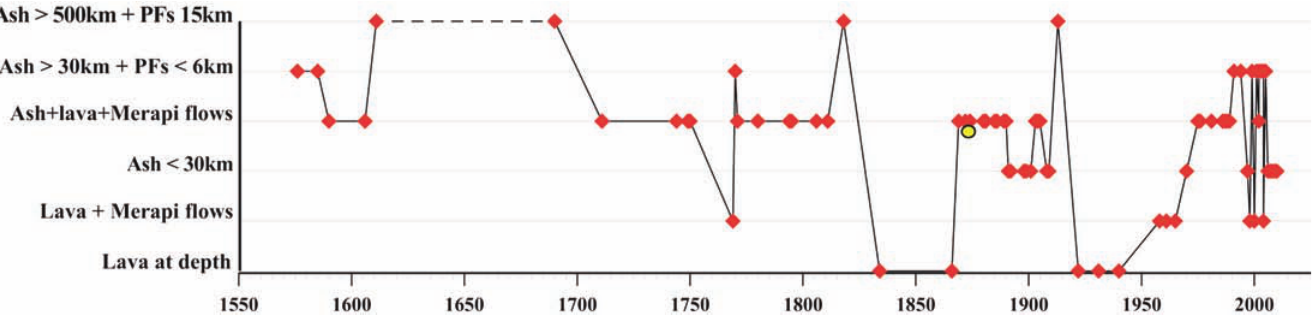
Figure 2. Colima Volcano historical activity. Based on: Tello 1651, Perez de Leon 1789, Mota Padilla 1742, Bárcena 1887, Puga 1889, Vizcarra 1891, Starr and Arreola 1903, Diaz 1906, Arreola 1915, Waitz 1932, Mooser 1961, Thorpe et al. 1977, Luhr and Carmichael 1982, Medina 1983, Flores 1987, Martin Del Pozzo and Romero 1988, De la Cruz 1993, Vizcaino 1993, Martin del Pozzo et al. 1995b, García-Acosta and Suárez 1996, Saucedo 1997, Breton et al. 2002, Reyes and De la Cruz 2002, Zobin et al. 2002, Navarro et al. 2003, Smithsonian Institution [1988, 1993, 2000], University of Colima Bulletin. : Lateral activity (Volcancito 1869-1873). Dashed line: no